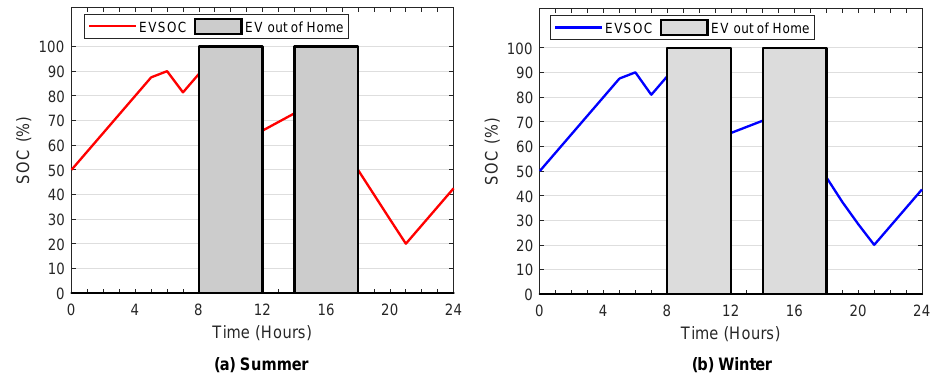
Figure 12. EV state of